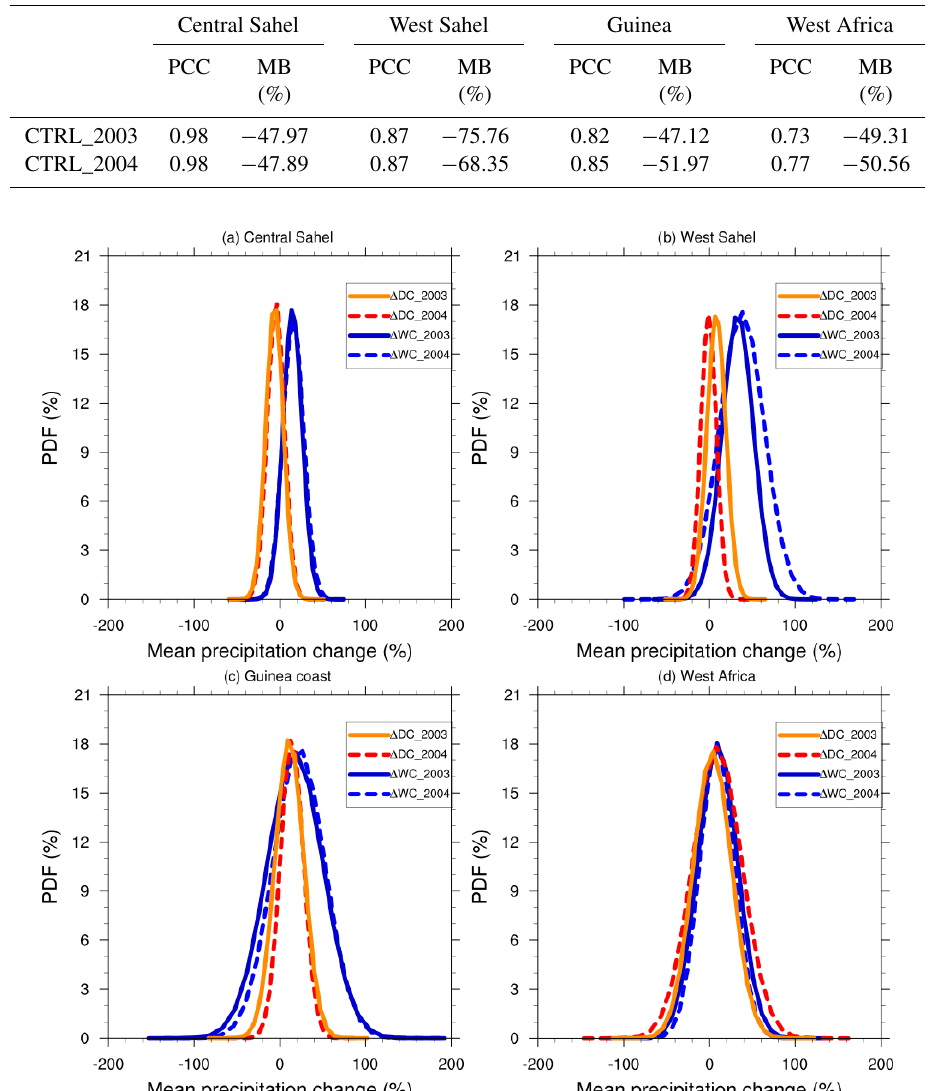
Figure 5. PDF distributions (%) of mean precipitation changes in JJAS 2003 and JJAS 2004 over the (a) Central Sahel, (b) West Sahel, (c) Guinea coast and (d) West Africa domains derived from dry ( (cid:49) DC) and wet ( (cid:49) WC) experiments compared to the control